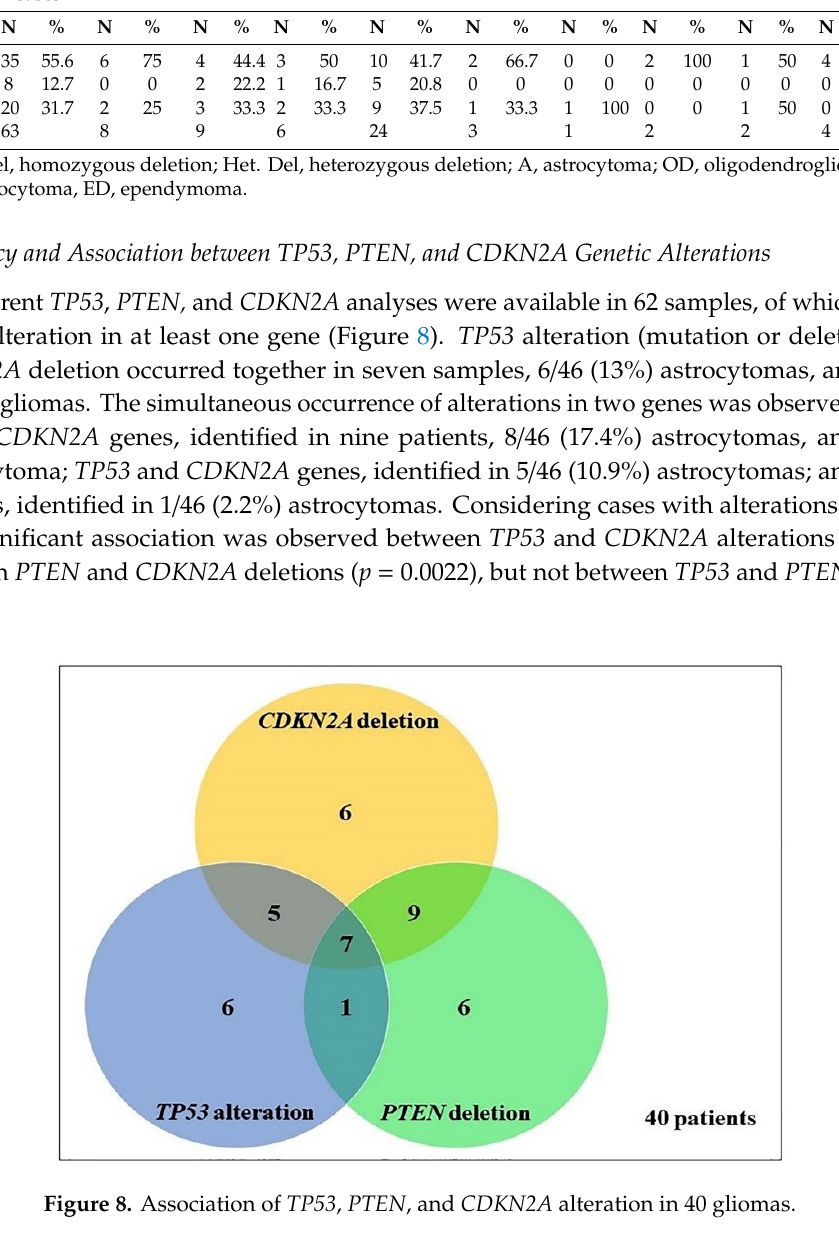
Table 6. Frequency of single and concurrent TP53 , PTEN, and CDKN2A alteration by WHO grade of malignancy.